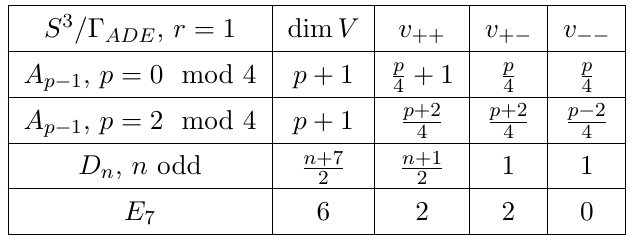
for (cid:7) = Z 2 . (cid:15) A (cid:15) B